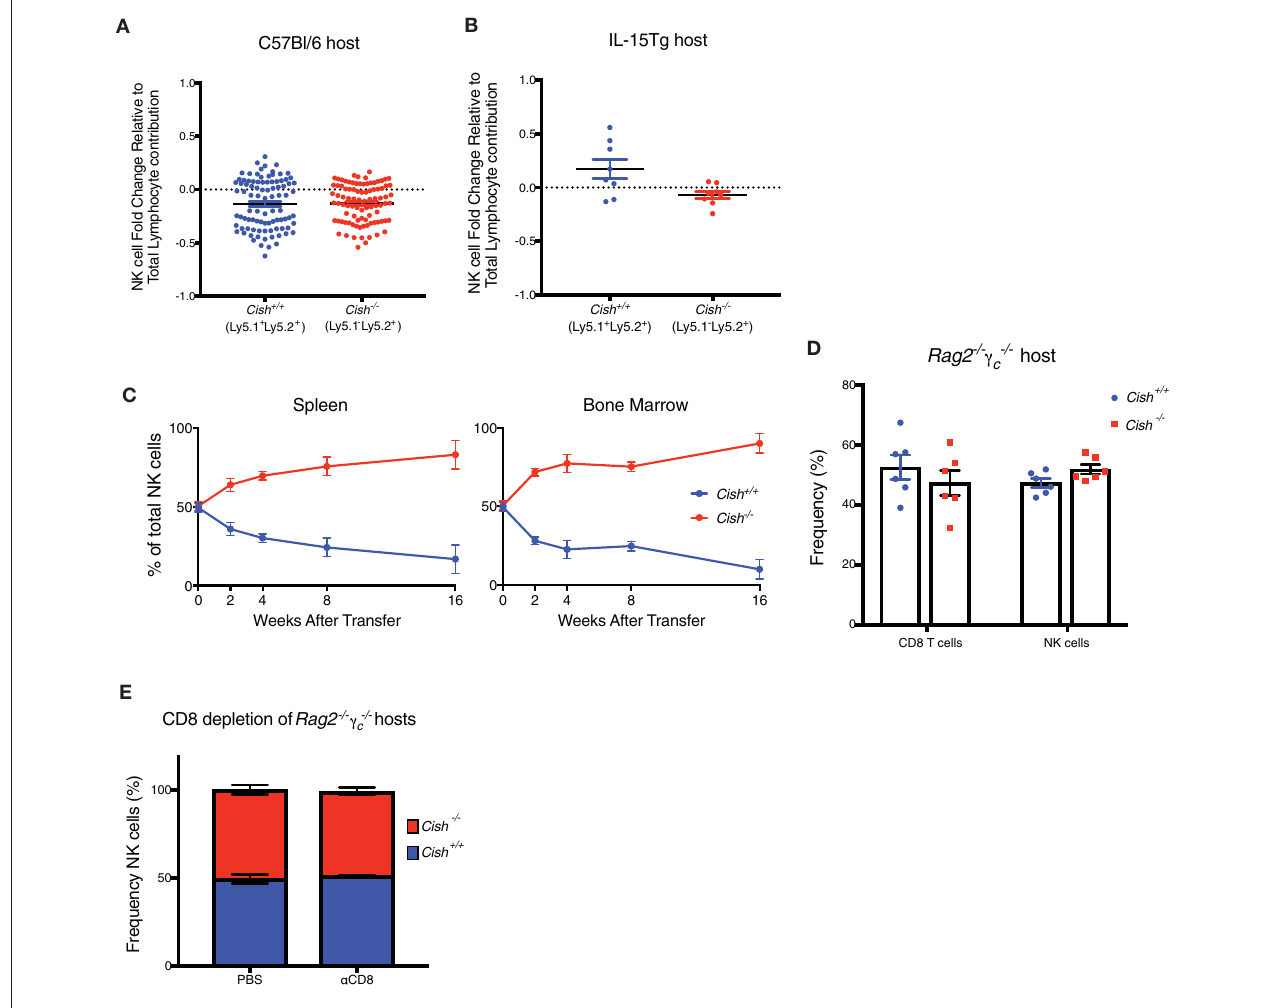
FIGURE 3 | IL-15 availability is a limiting factor for the homeostatic expansion of CIS-Deficient NK Cells in vivo . (A,B) Haematopoietic chimeras were generated by injecting irradiated host mice (C57Bl/6 or IL-15Tg) with equal amounts of control Cish + / + (Ly5.1 + Ly5.2 + ) and Cish − / − (Ly5.2 + ) bone marrow. After 6 weeks, NK1.1 + NKp46 + CD49b + cells were analyzed for expression of Ly5.1 and Ly5.2 to deduce donor origin). (C) Adoptive transfer models were generated by injecting Rag2 − / − γ − / − c mice with 1 × 10 5 FACS sorted Cish + / + (Ly5.1 + Ly5.2 + ) and Cish − / − (Ly5.2 + ) NK1.1 + NKp46 + CD49b + NK cells. NK cells from the spleen (left panel) and BM (right panel) were analyzed for expression of Ly5.1 and Ly5.2 to deduce donor origin at indicated time points. (D) Haematopoietic chimeras were generated using irradiated Rag2 − / − γ c − / − mice as hosts and NK and T cells from each donor were assessed as described earlier. (E) Reconstituted Rag2 − / − γ c − / − mice were injected i.p. once per week for 4 weeks with anti-CD8 to deplete T cells, and splenic NK cells were analyzed for expression of Ly5.1 and Ly5.2 to deduce donor origin in control (PBS treated) or α CD8 treated reconstituted Rag2 − / − γ − / − c hosts. ( A,B , n ≥ 4 biological replicates mean ± s.e.m.; C , mean ± s.e.m. of n = 3 biological replicates at each timepoint; D,E, n = 6 biological replicates mean ±